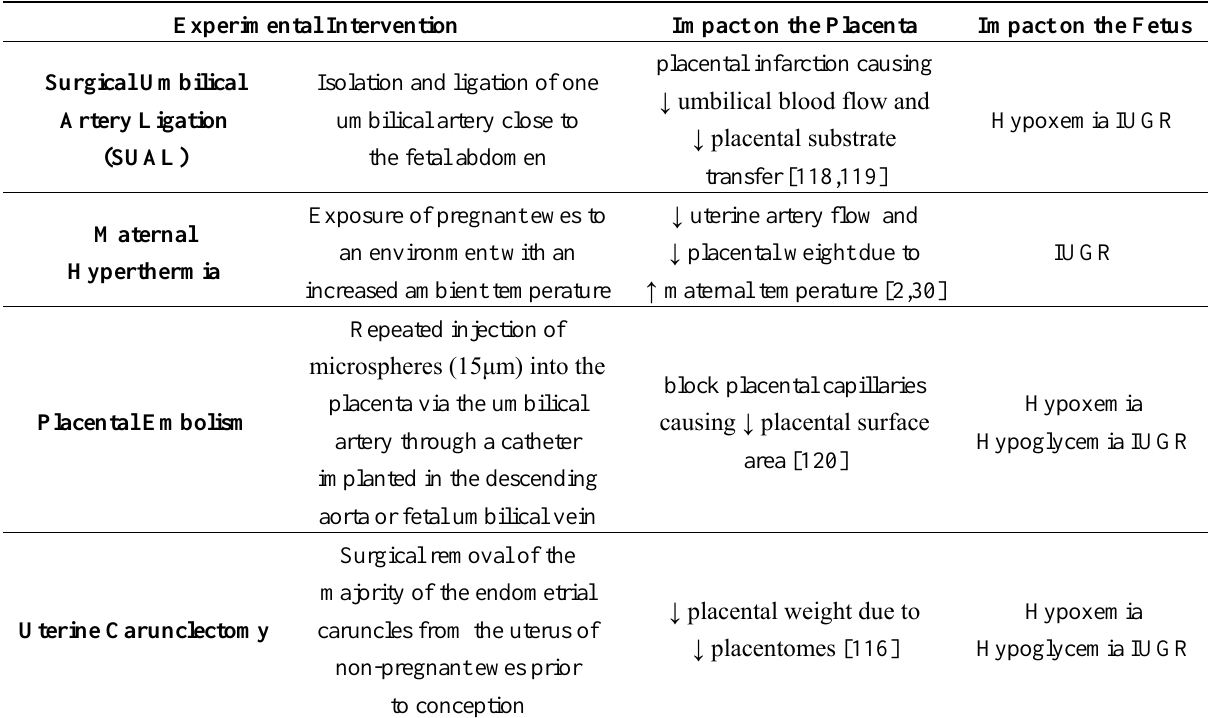
Table 2. Summary of experimental models of placental insufficiency and their impact on the placenta and the